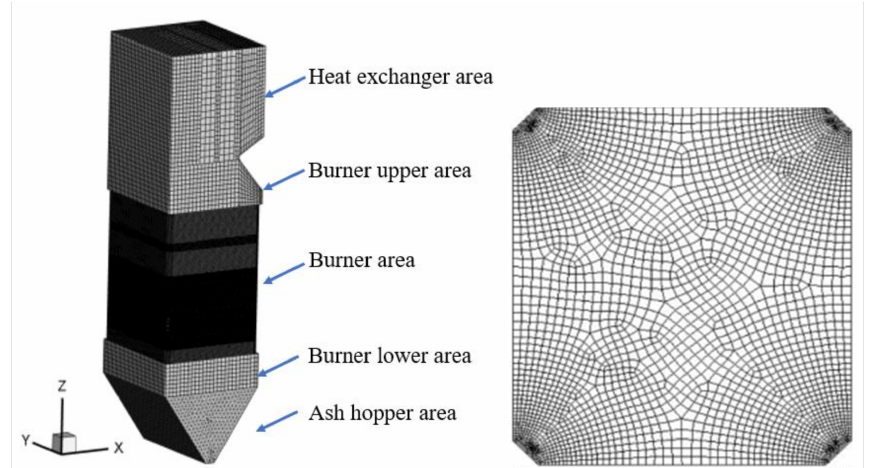
Figure 3. Grid division of